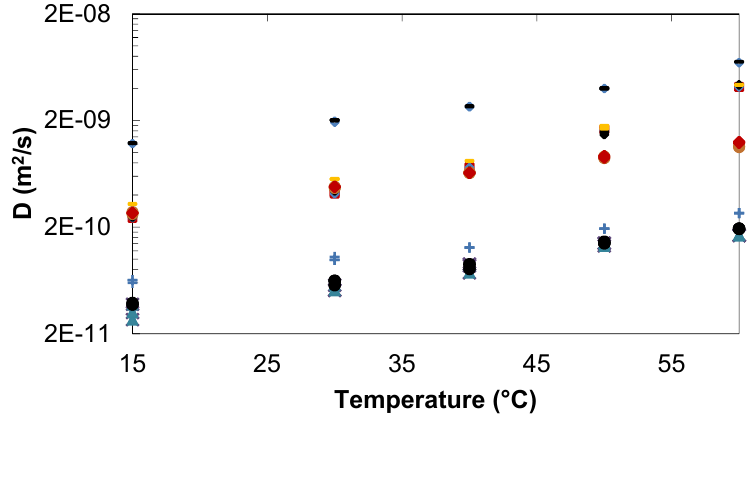
Figure 3. Diffusion of trehalose, lactose, glucose and water in trehalose/lactose/water and trehalose/glucose/water solutions. Tre/Lac 34/34 mg/mL: ♦ Tre, ■ Lac, D Tre/Glc 35/20 mg/mL: ♦ Tre, (cid:31)(cid:31)(cid:31) Glc, (cid:31)(cid:31) D ● D O. Tre/Glc 785/67 mg/mL: ● Tre, +Glc, ♦ D 2